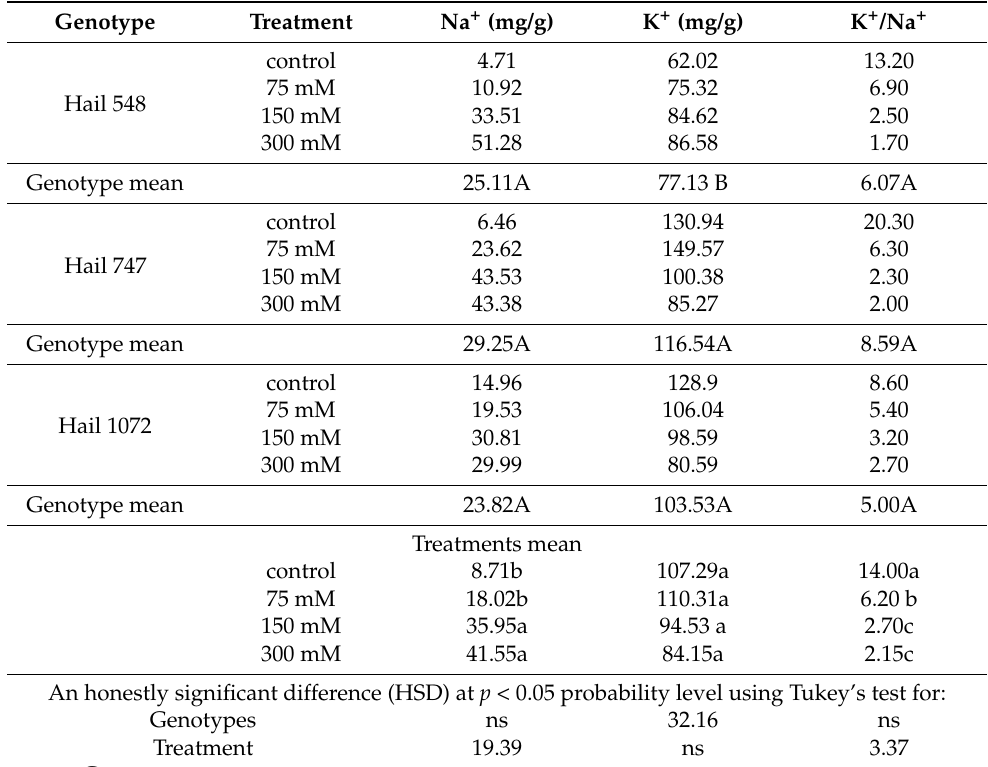
Table 6. Content of sodium (Na), potassium (K), and K/Na ratio for three Hail landraces under four NaCl stress treatments. Values are the mean of four replications. According to Tukey’s test, different letters within the same columns show significant differences ( p < 0.05). The higher cases are the differences among genotypes, and the lower cases are the differences among treatments’ mean. ns: means not